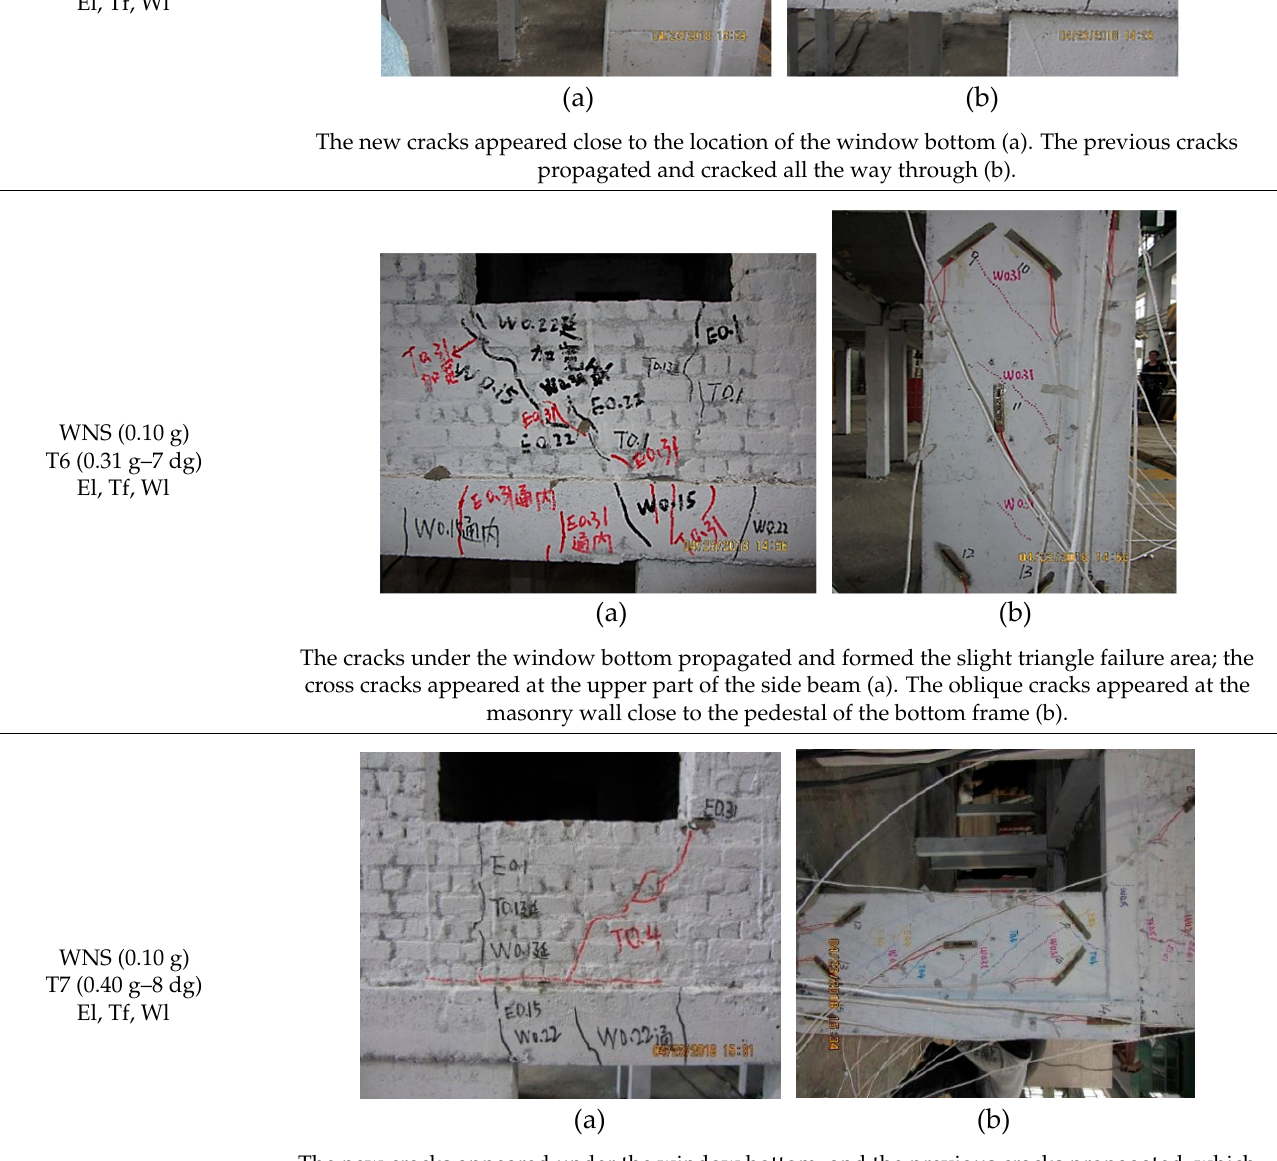
The new cracks appeared under the window bottom, and the previous cracks